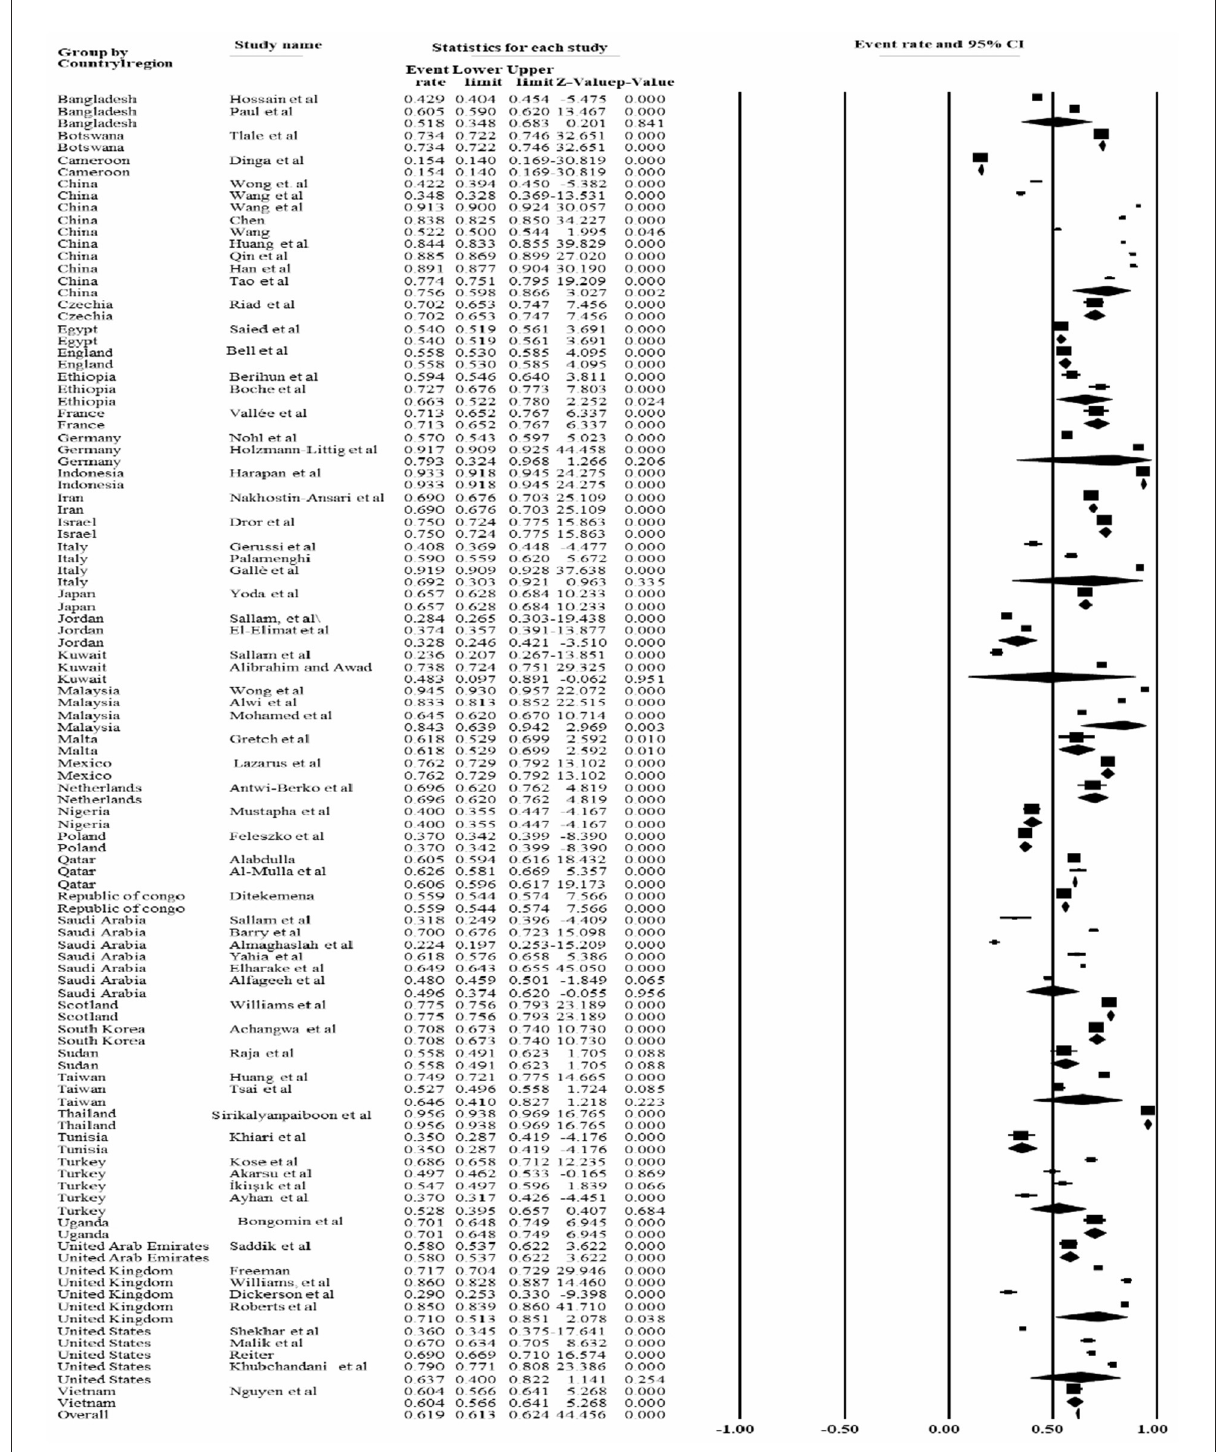
FIGURE6 Forest plot shows the subgroup analysis of the pooled COVID-19 vaccine rate based on the country where the studies were conducted,